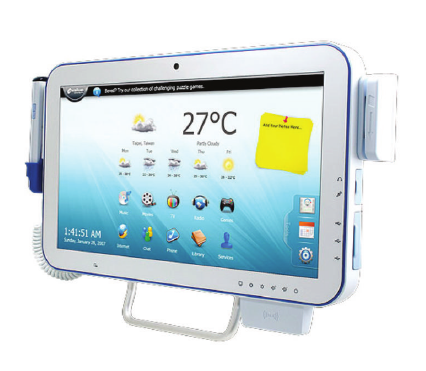
Figure 2: Terminal care of a Value Technology Inc. (MCT) [9].